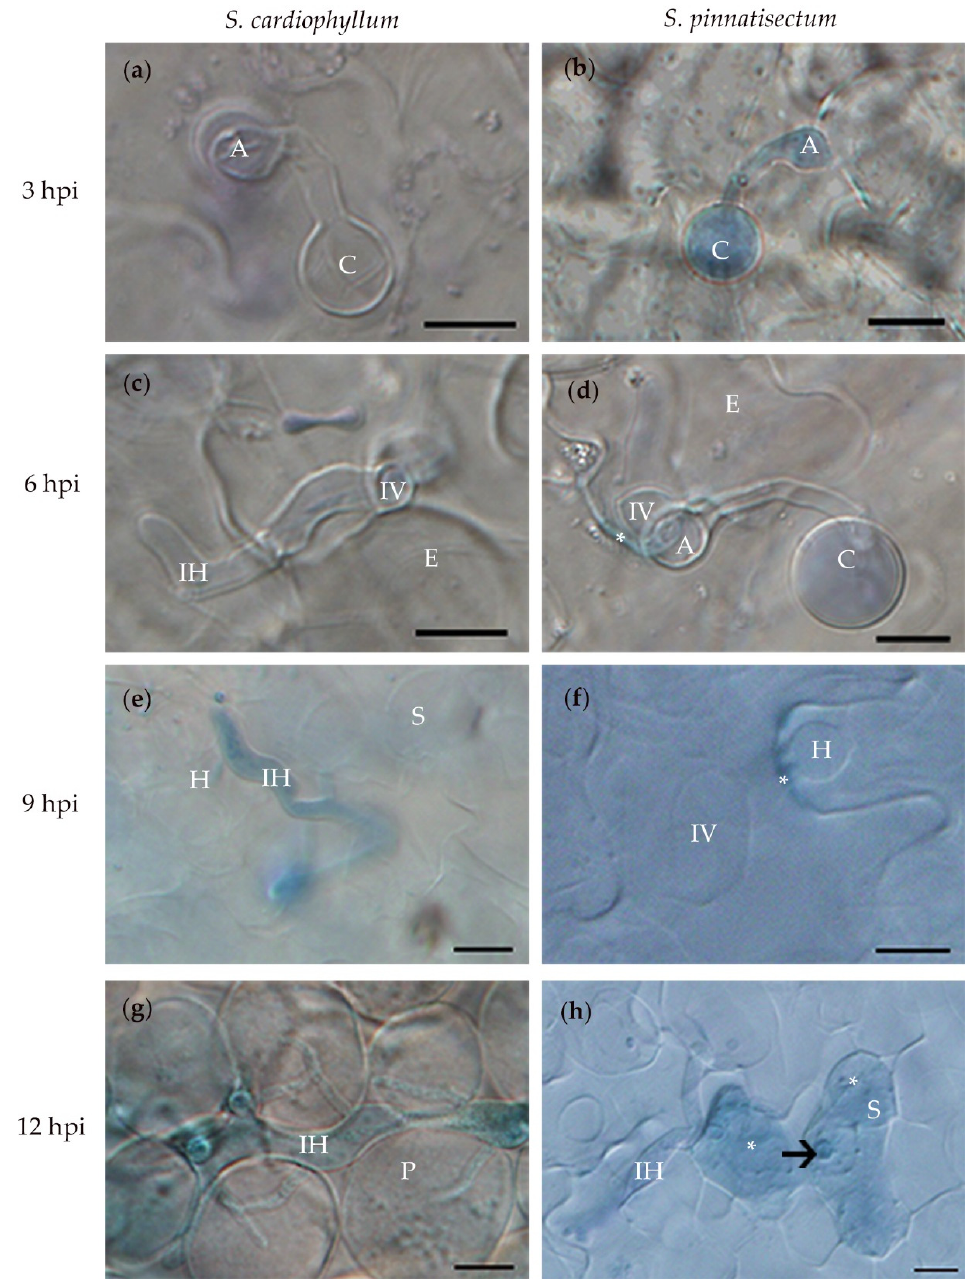
Figure 2. Microscopic characterization of Solanum pinnatisectum and Solanum cardiophyllum interacted with Phytophthora infestans at di ff erent times post-inoculation. ( a ) and ( b ), the germinated cysts with appressorium at the tip on the leaf surface of S. cardiophyllum and S. pinnatisectum 3 h post-inoculation (hpi), respectively. ( c ) and ( d ), the pathogen penetrated into the epidermal cell of S. cardiophyllum and S. pinnatisectum 6 hpi, * in (d) indicates cell wall deposition at the infection site of epidermal cell on S. pinnatisectum . ( e ) Intercellular hyphae with haustoria invade spongy cells of S. cardiophyllum 9 hpi. ( f ) The pathogen extends underneath the cuticle as the infection vessel and forms haustoria in the epidermal cells of S. pinnatisectum 9 hpi. ( g ) Intercellular hyphae expand with multiple branches in the palisade cells of S. cardiophyllum 12 hpi. ( h ) Penetration of intercellular hyphae is stopped by the necrosis of mesophyll cells on S. pinnatisectum 12 hpi; the haustorium is pointed by the arrow; and the deeply blue-stained tissues indicate cell necrosis (indicate as *). A: appressorium, C: cyst, E: epidermal cell, H: haustorium, IH: intercellular hyphae, IV: infection vessel, P: palisade cell, S: sponge cell. Bar = 10 µ